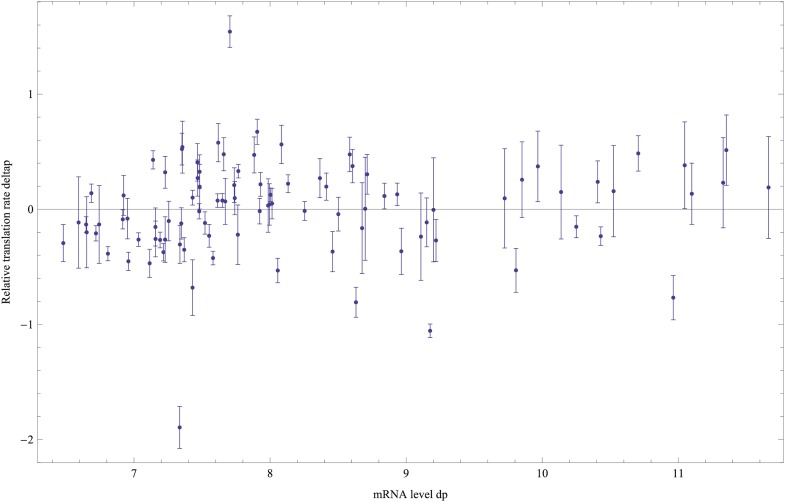
Estimated relative log-translation rates δp and their error bars σ(δp) (vertical axis) as a function of the log-mRNA level relative to ihfB, dP, for each promoter p.